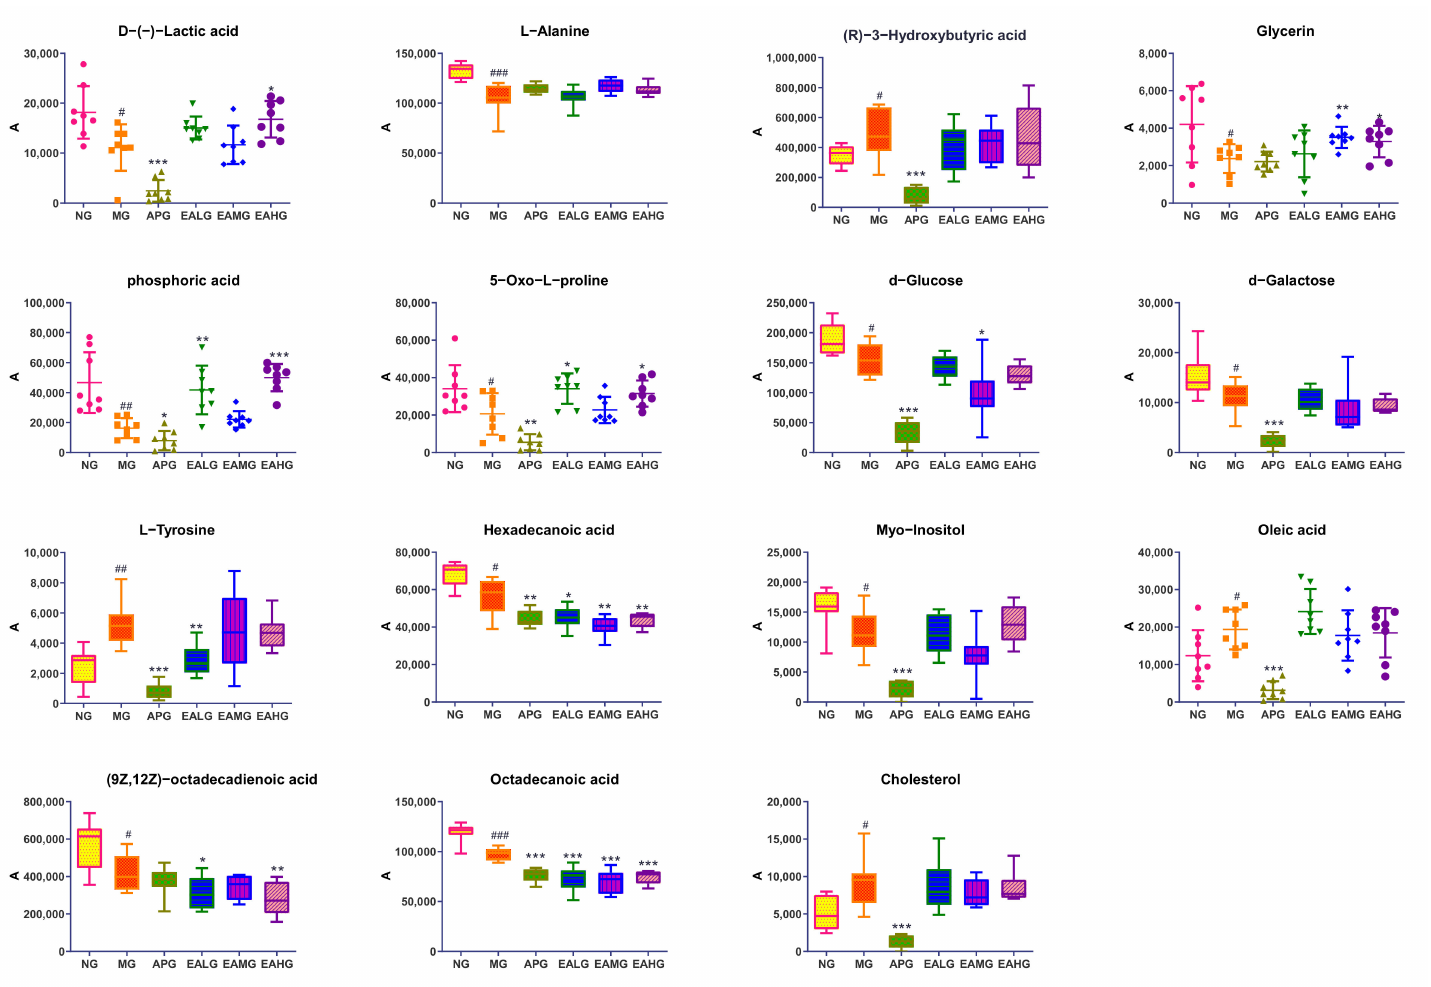
Figure 7. Box diagram of 15 differential metabolites in serum # p < 0.05, ## p < 0.01, ### p < 0.001 vs. NG; * p < 0.05, ** p < 0.01, *** p < 0.001 vs.